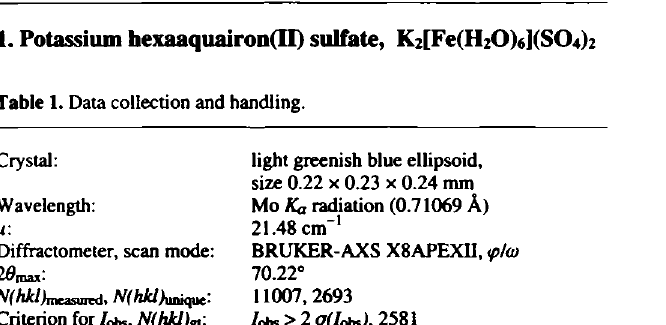
Table 1. Data collection and handling.